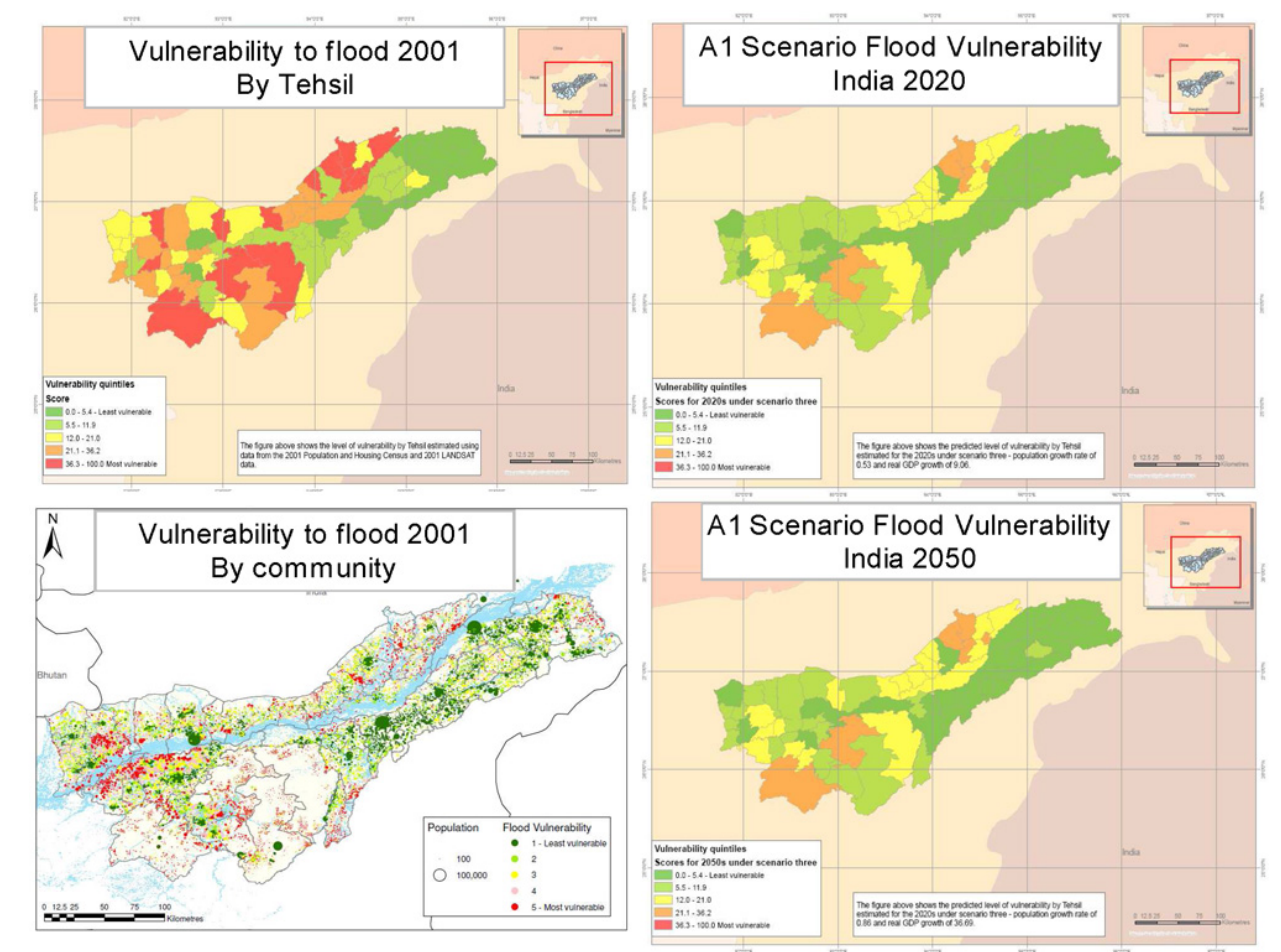
Figure 5. Estimates of vulnerability based upon know variables for 2001 at both a community and Tehsil level. The estimates of vulnerability to flood in 2020 and 2050 under SRES A1 (example) utilise TERI estimates of GDP and poulation and model the impact of these estimates on specific indicators of overall